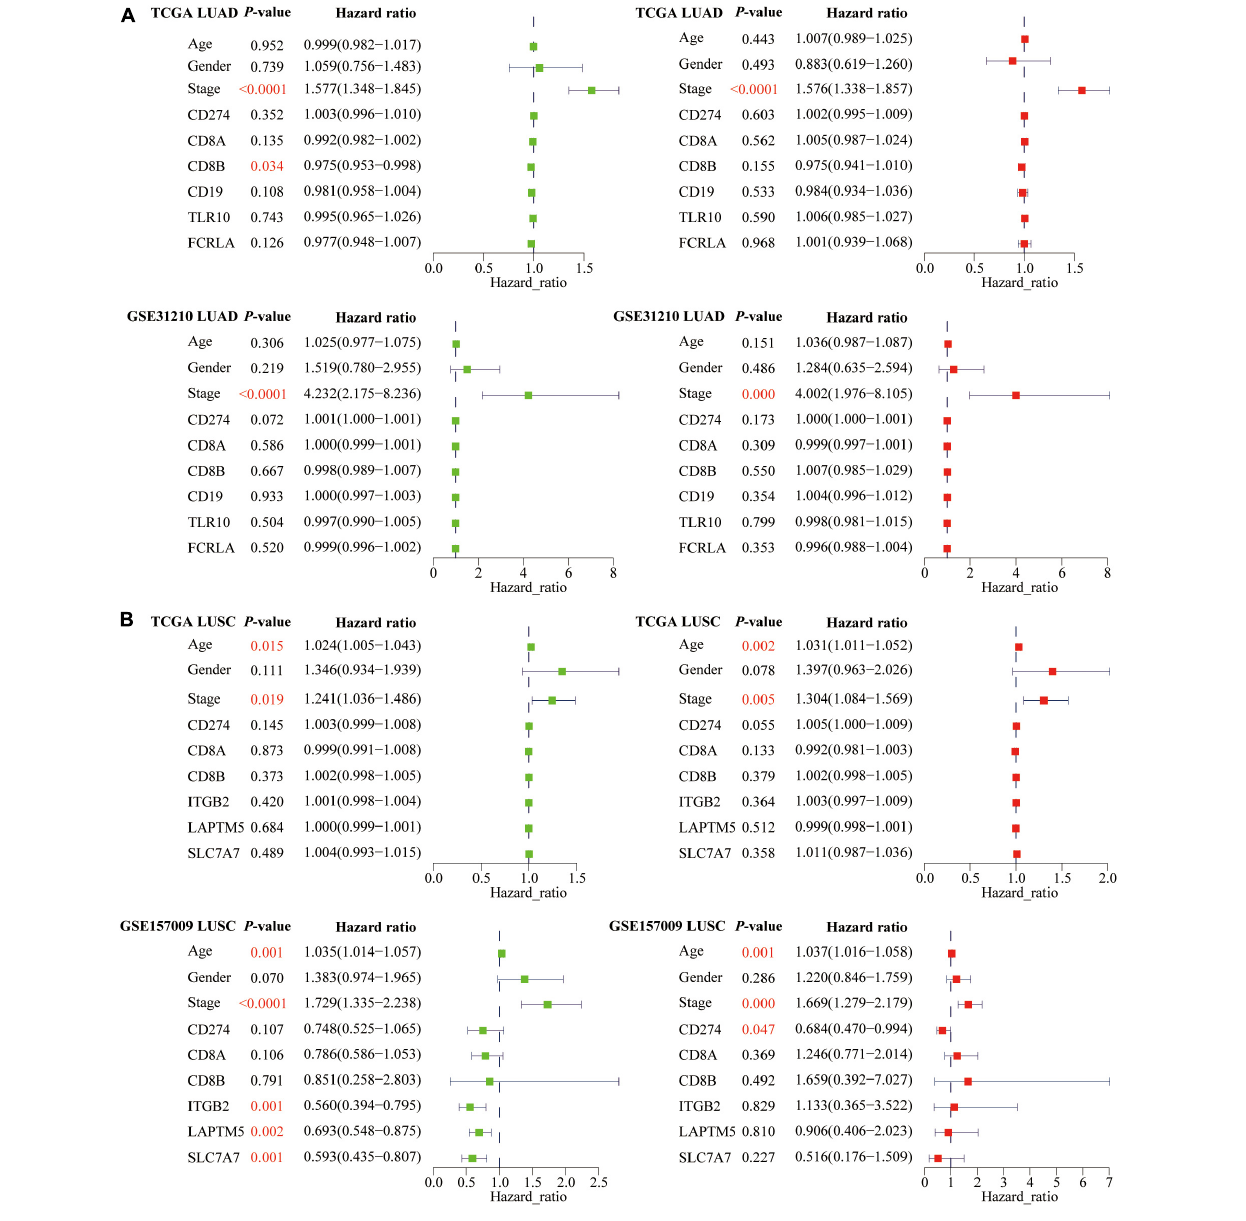
FIGURE 11 | The prognostic significance of PD-L1, CD8A, CD8B, and six hub genes in lung cancer. For (A) LUAD and (B) LUSC patients, we performed univariate and multivariate Cox regression analyses. Green represents single factor, and red represents multiple factors. P -values of independent prognostic factors are marked in